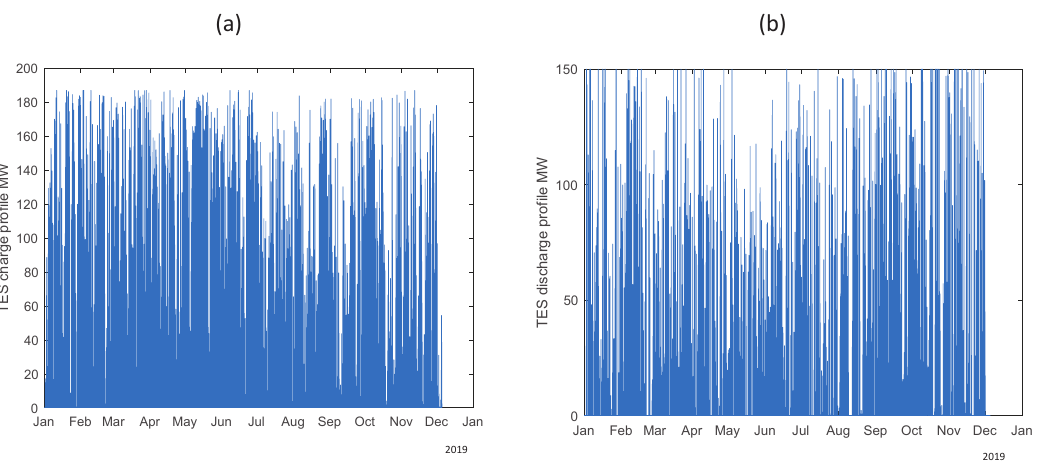
Figure 16. Charge ( a ), Discharge ( b ) profile for BESS.